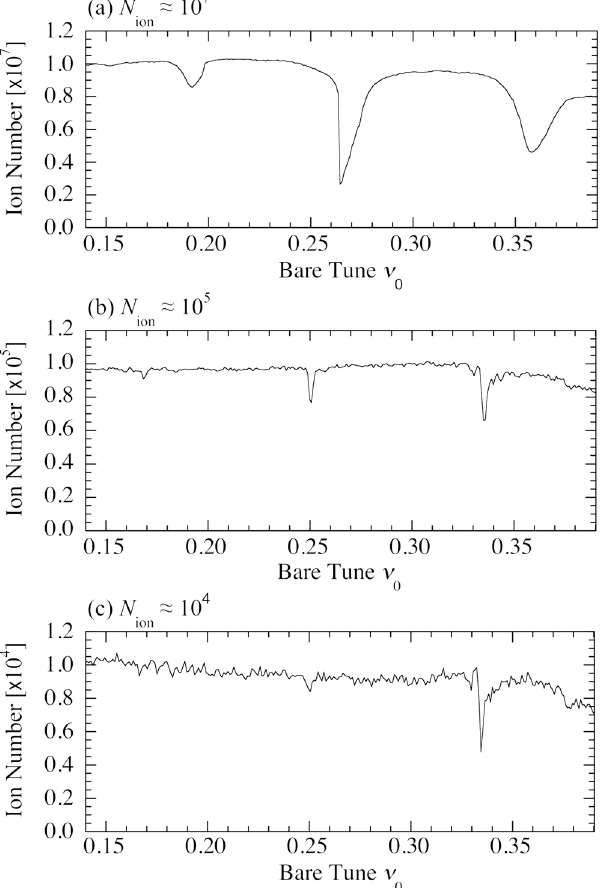
FIG. 24. Dependence of the three major stop bands on plasma intensity. The number of ions remaining in the LPT after 10 4 AG periods is measured in S-POD at over 200 different operating points. The horizontal and vertical bare tunes are always equalized, i.e., ν 0 x ¼ ν 0 y ð ≡ ν 0 Þ , which means that the experiment has been performed along the straight line ν 0 x − ν 0 y ¼ 0 in the tune diagram. The initial ion number N in the LPT is decreased ion ≈ 10 7 , (b) N ≈ 10 5 , from the top panel to the lower: (a) N ion ion ≈ 10 4 and (c) N ion